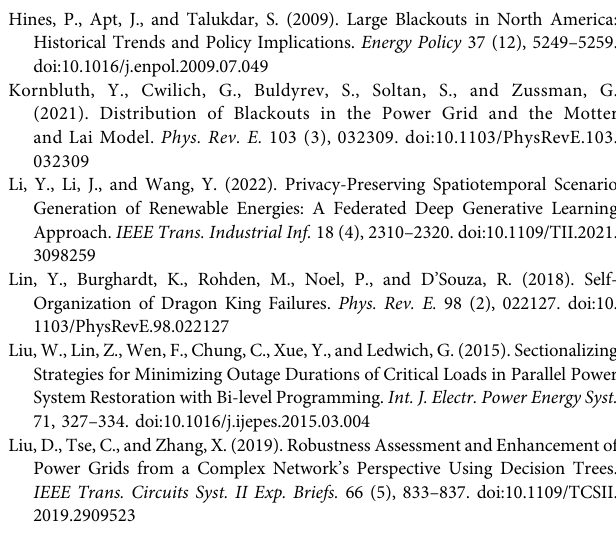
Objective of load shedding